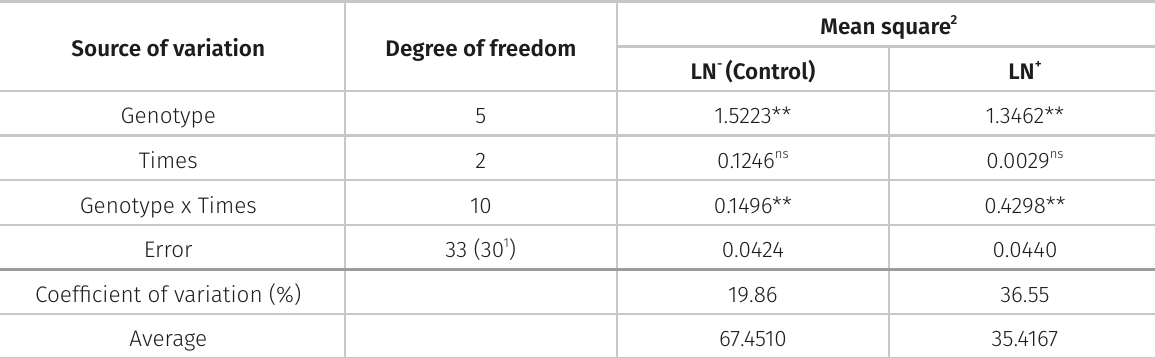
Table I. Analysis of variance of the regeneration rate after cryopreservation of pineapple accessions/hybrids in function of different culture times of the starting material.